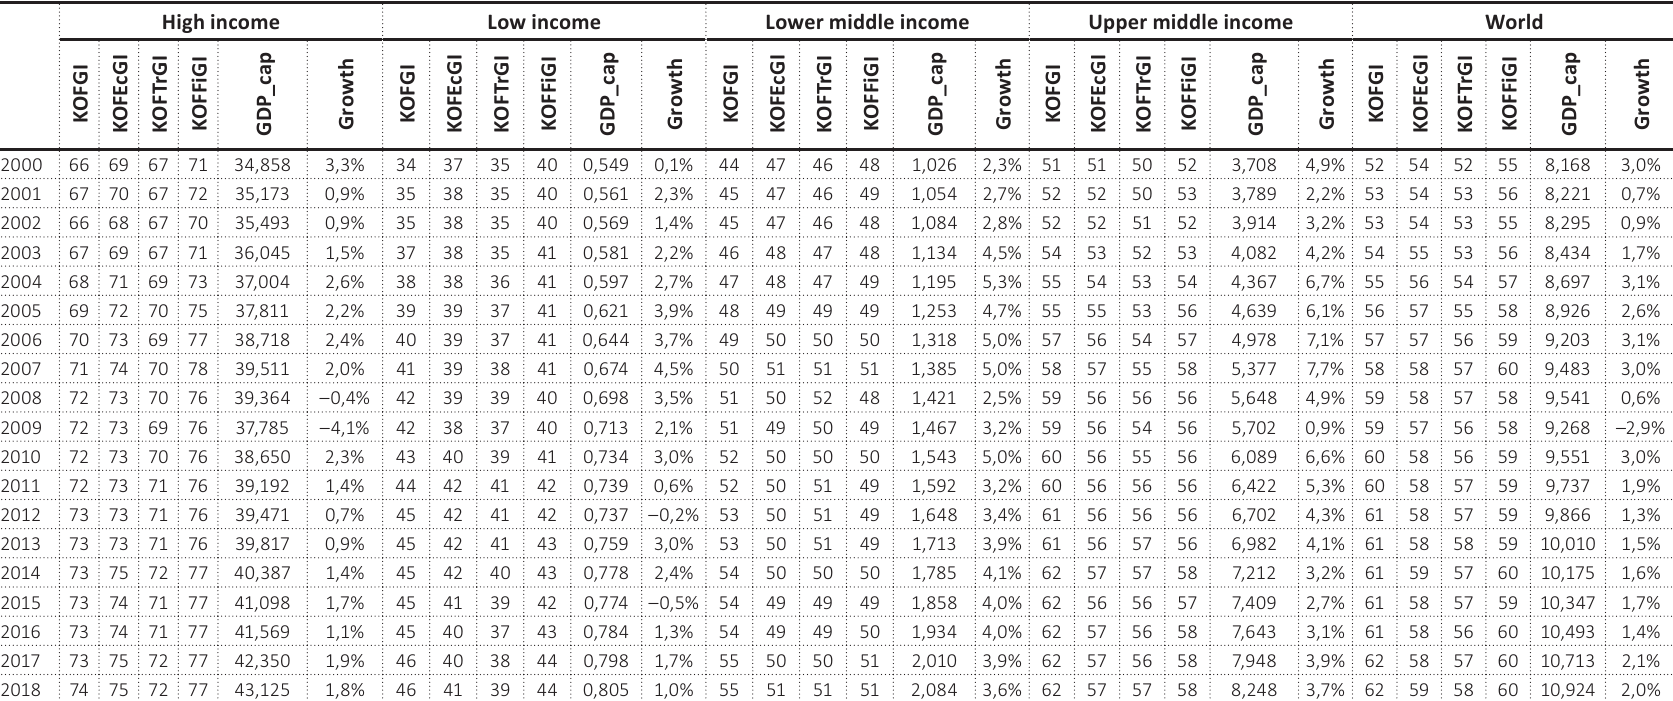
Table B1 (cont.). GDP per capita, growth and KOF indices of globalization by income